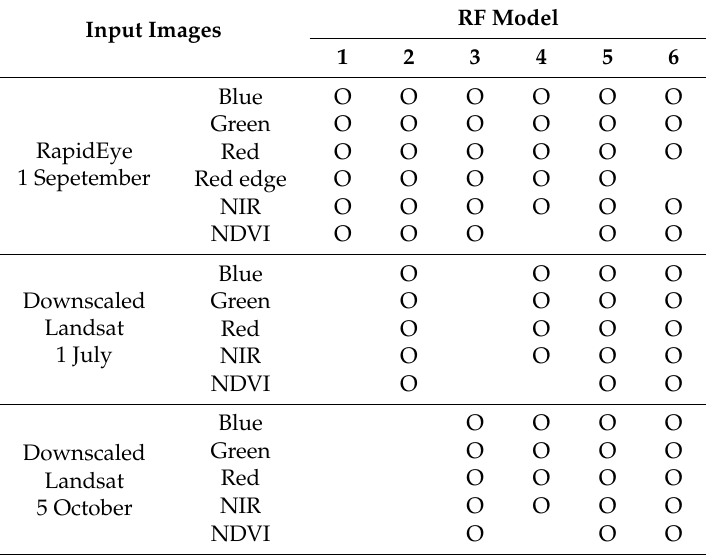
Table 1. Image bands used for